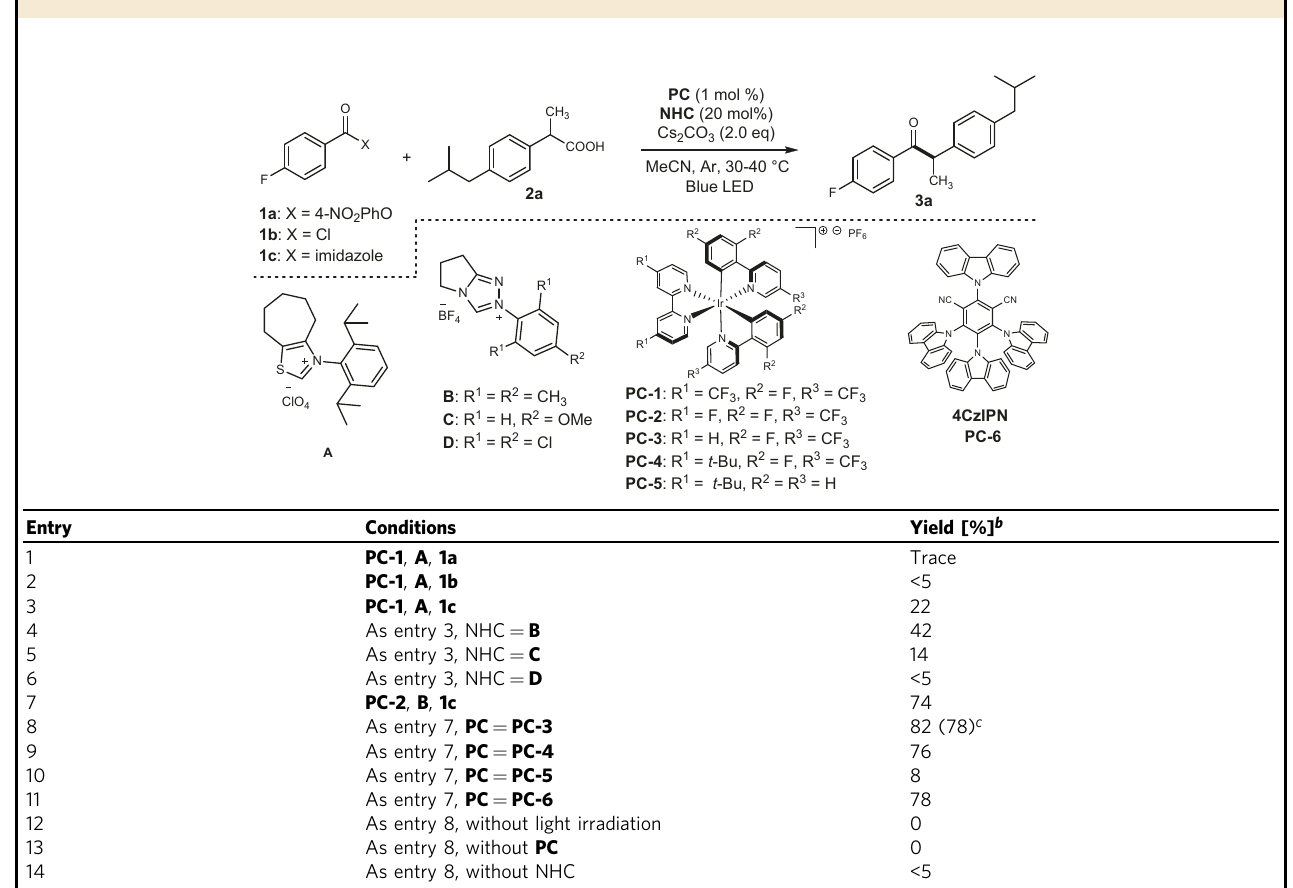
Table 1 Optimization of the reaction conditions a